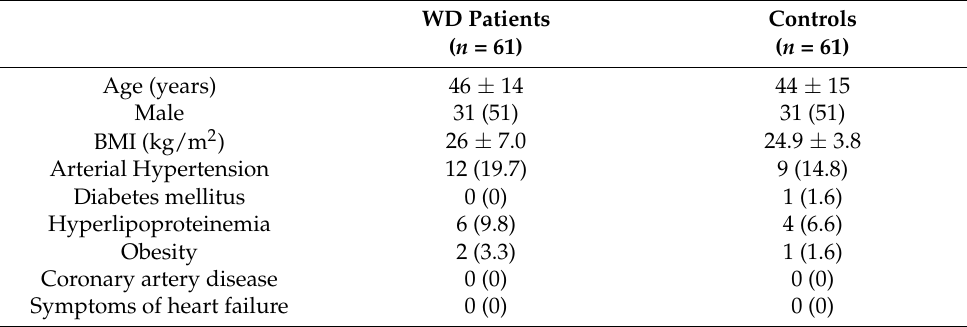
Table 1. Demographic and clinical parameters of the study